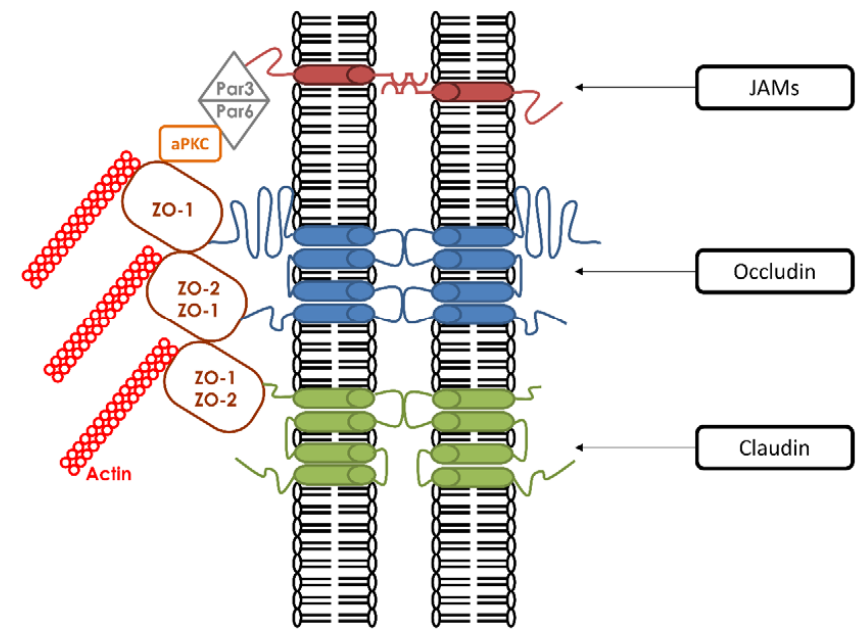
Figure 1. Molecular components of tight junctions. They are composed of three families of transmembrane proteins that include Occludins, Claudins, and Junctional Adhesion Molecule (JAMs). Every transmembrane protein is associated with cytoplasmic adaptor proteins such as the zonula occludens proteins ZO ‐ 1 and ZO ‐ 2. These interactions are mediated through their cytosolic tails. Other interactions occur between ZO proteins and additional cytoplasmic proteins (Par6, Par3, and aPKC). ZO proteins are also connected with the actin